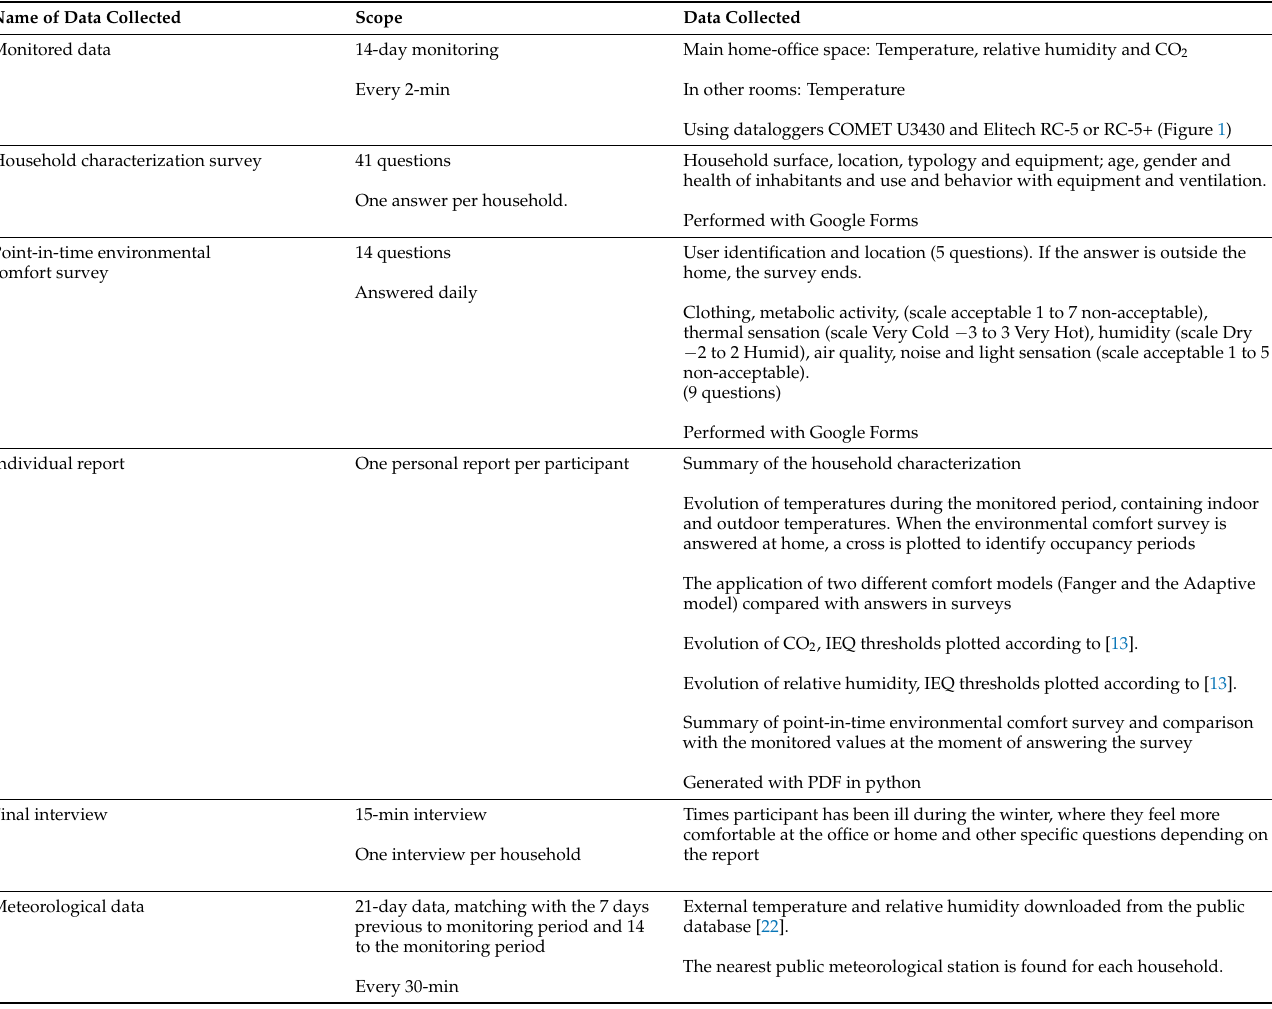
Table 1. Summary of the data collected and